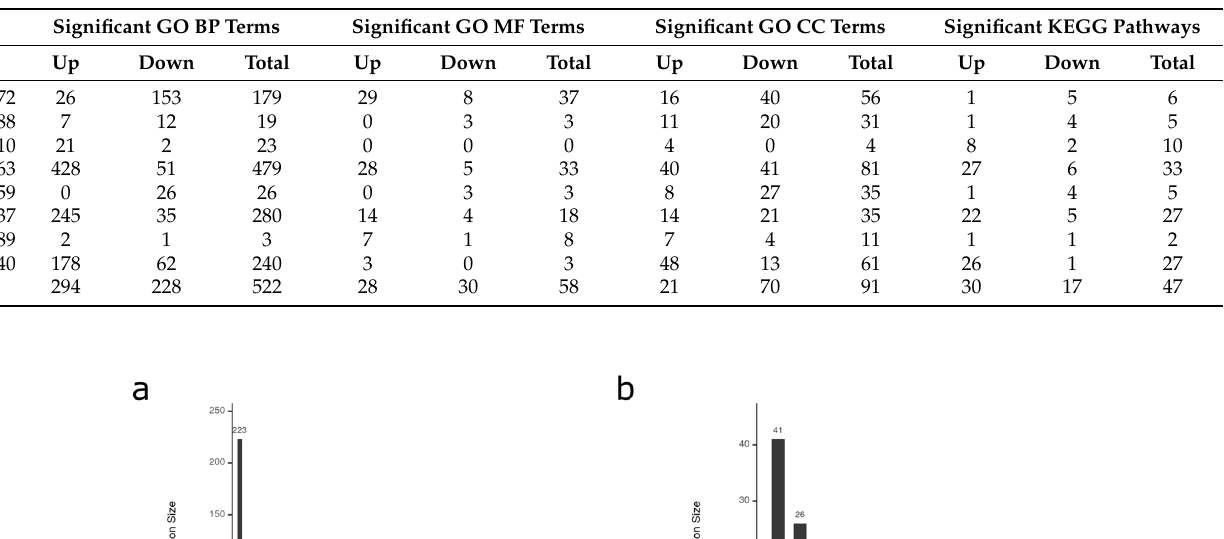
Table 2. Summary of functional enrichment analysis results by Gene Ontology functions (BP: Biological Process, MF: Molecular Functions, CC: Cellular Component), and KEGG pathways. “Up” terms are overrepresented in female lung adenocarcinoma patients, while “Down” terms are overrepresented in male lung adenocarcinoma patients.